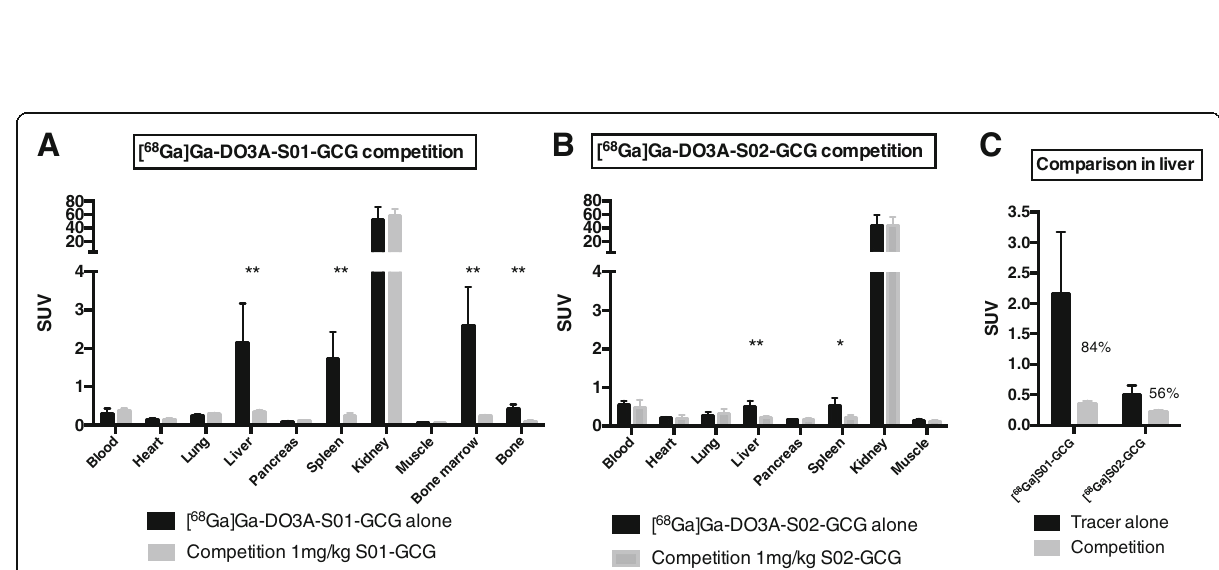
Fig. 5 Hepatic binding of [ 68 Ga]Ga-DO3A-S01-GCG and [ 68 Ga]Ga-DO3A-S02-GCG can be competed away. [ 68 Ga]Ga-DO3A-S01-GCG binding in the liver, spleen, and bone marrow, but not other tissues, could be competed away by co-injection with 1 mg/kg precursor peptide ( a ). Similarly, [ 68 Ga]Ga-DO3A-S02-GCG binding in the liver and spleen could be competed away by 1 mg/kg precursor peptide ( b ), but to a lesser extent than for [ 68 Ga]Ga-DO3A-S01-GCG ( c ). Each bar represents the average of n = 4